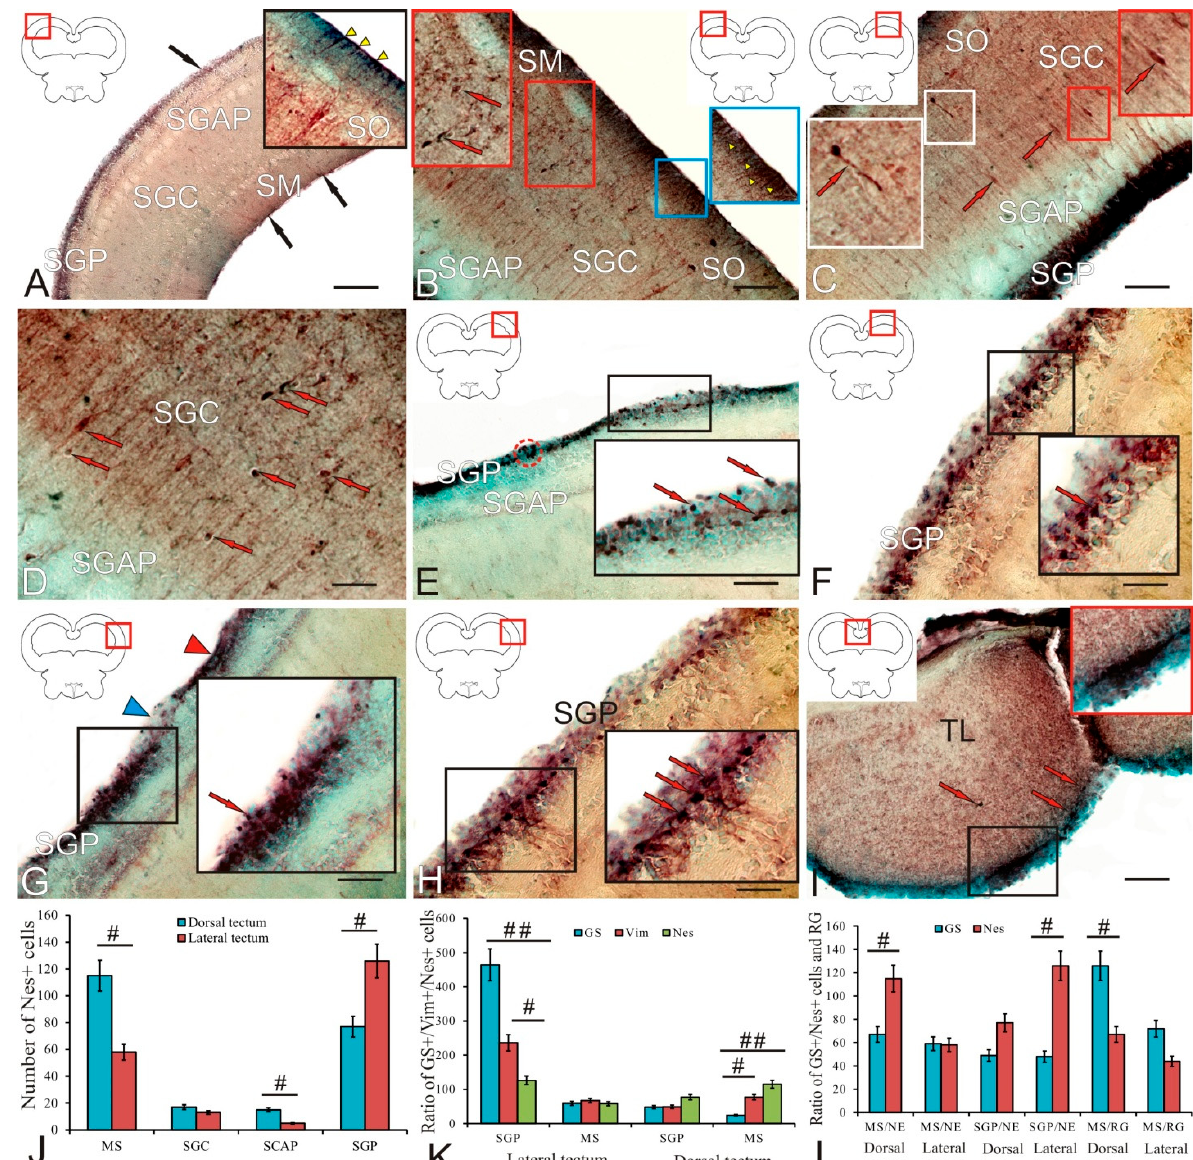
Figure 8. Nestin in the optic tectum of trout, Oncorhynchus mykiss : ( A ) a general view of nestin immunolabeling in the dorsolateral tectum of Nes+ NE type cells (black arrows) and Nes+ RG (yellow arrowheads); ( B ) Nes+ cells in SM (blue box) and moderately labeled Nes+ cells (red arrows) in SGC (red box); ( C ) intensely labeled cells (red arrows) with processes (white inset) in SGC and elongated bipolar cells (red inset) in SGAP; ( D ) different types of Nes+ cells (red arrows) in SGC; ( E ) local clusters of Nes+ cells (red dotted oval) and diffuse clusters (inset) of intensely labeled cells (red arrows) in SGP of the dorsolateral tectum; ( F ) a diffuse pattern of distribution of Nes+ cells in SGP (inset) in the dorsal tectum; ( G ) extensive densely labeled clusters of Nes+ cells (red arrowheads) in SGP (inset, single Nes+ cells indicated by red arrows), alternating with areas that lack immunopositive cells (blue arrowhead); ( H ) intensely labeled cells (red arrows) located diffusely in the basal part of SGP (inset); ( I ) Nes+ cells (red arrows) and clusters (inset) in the longitudinal torus (TL). Scale bars: ( A ) 200 µ m, ( B , C , E , G , I ) 100 µ m, and ( D , F , H ) 50 µ m. ( J ) A comparative